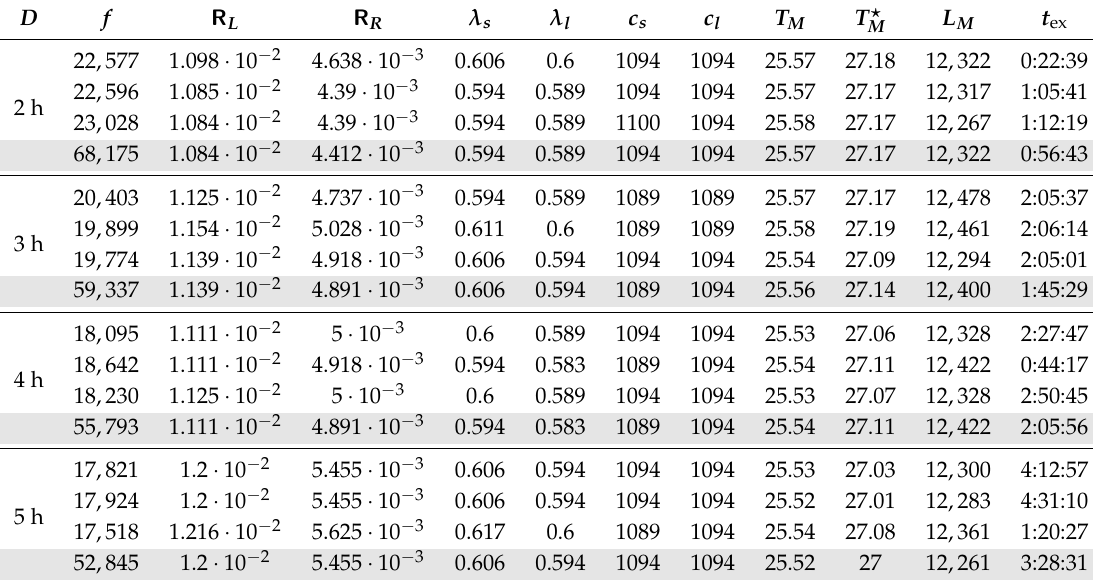
Table A1. 12.4% w -PCM mortar: values of the identified parameters for each heating/cooling ramp and for the first, second, third, and all cycles together cases.